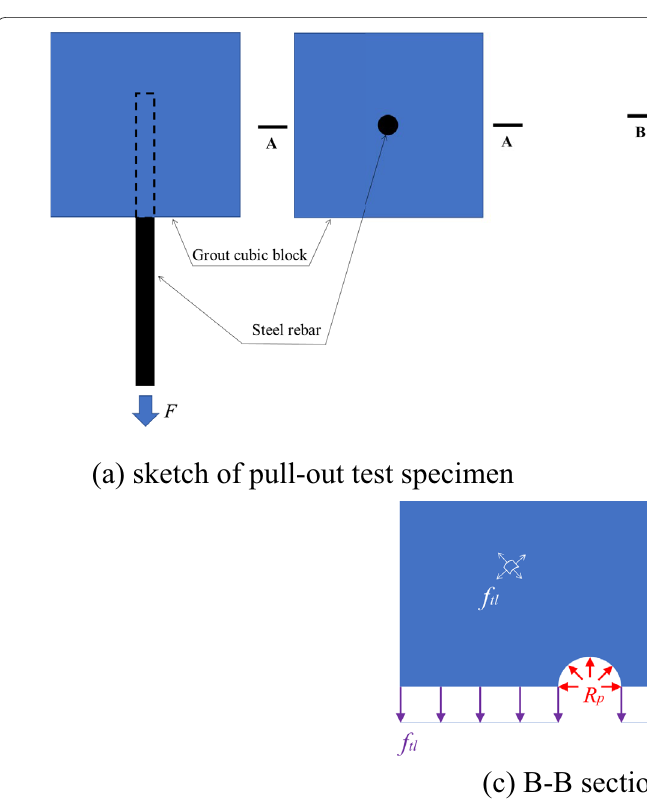
Fig. 1 Force mechanism between grout and steel rebar.